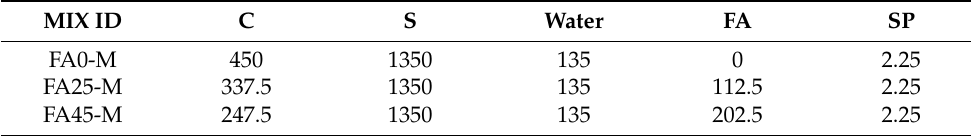
Table 4. Mix proportions of mortar (kg/m 3 ).